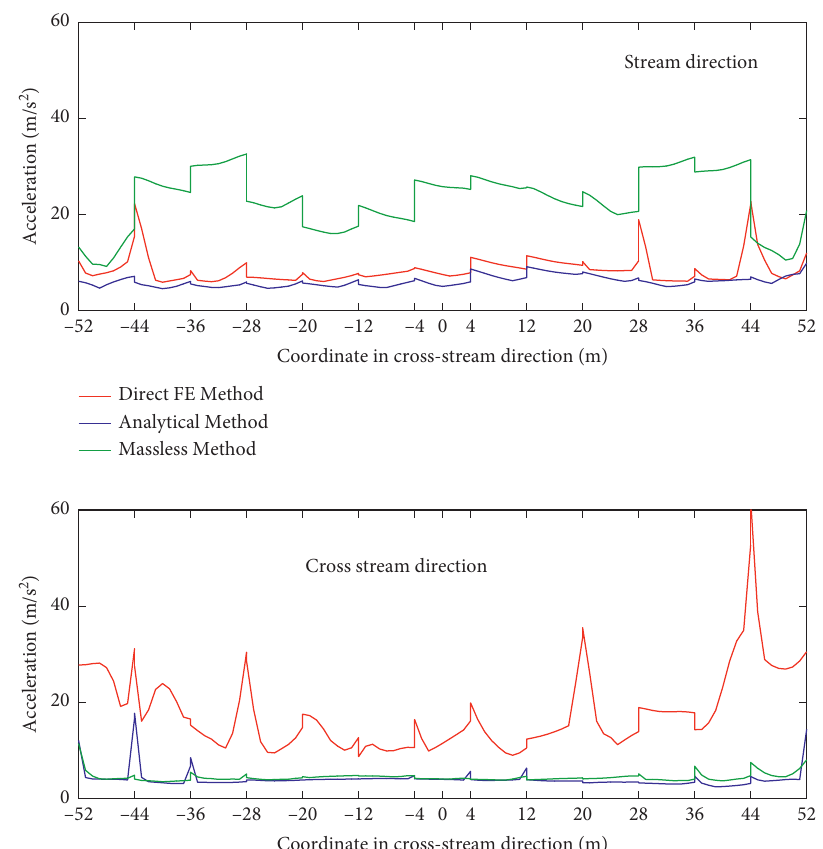
Figure 14: Distribution of PGA at upstream side of the buttress dam along crest induced by the Taft earthquake in the (a) stream and the (b) cross-stream direction for foundation modelling using direct FE method, the analytical method, and the massless